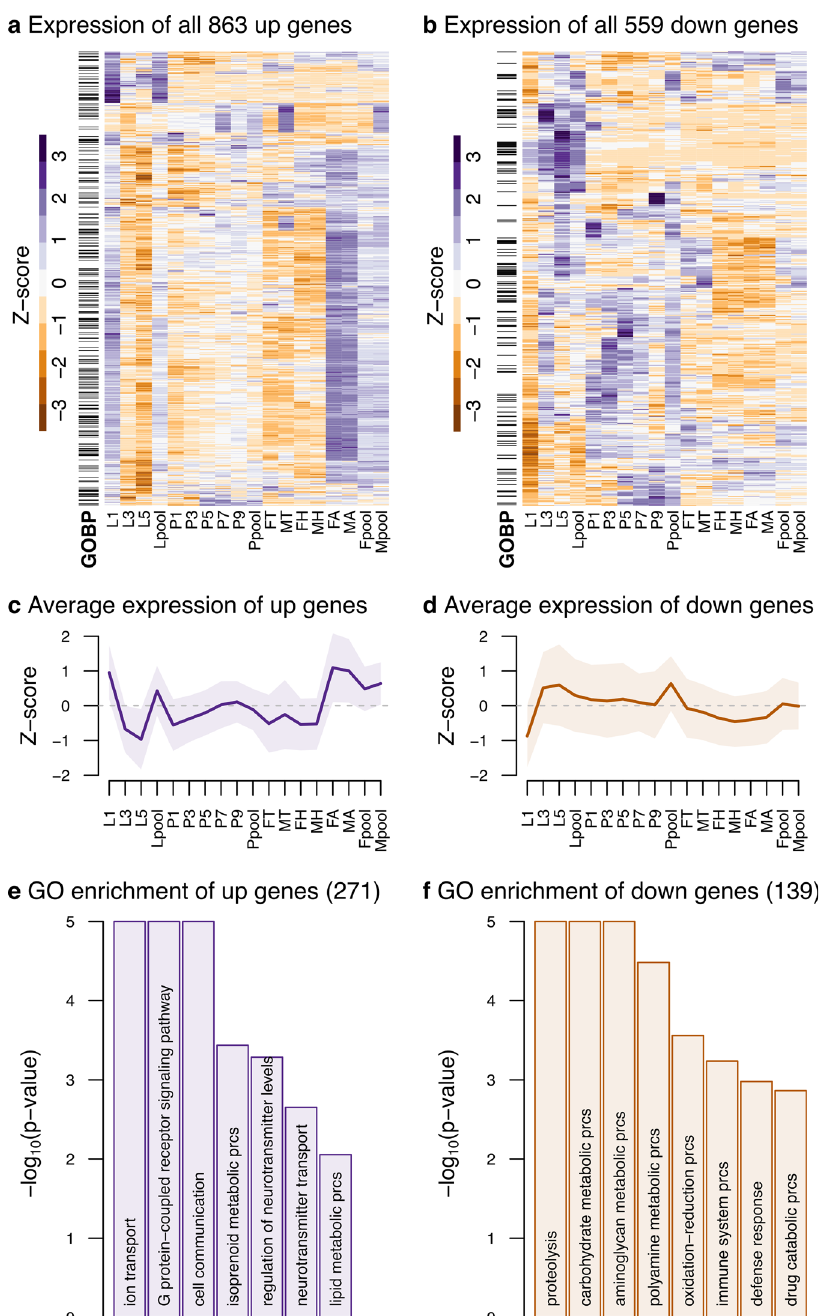
Fig. 3 Differential expression results for the L1:L contrast. a , b Heatmaps of differentially upregulated and downregulated genes (5% FDR) in L1 relative to the average of L3 and L5. The average of each pair of replicates is used for the columns, and the rows are scaled using a Z-score. c , d Average gene expression trend based on the Z-score scaled expression of all upregulated and downregulated genes across all samples, respectively. The shaded area represents ±1 SD from the mean. e , f Topmost signi fi cantly enriched Biological Process GO terms amongst upregulated and downregulated genes, respectively. Only GO terms with an associated q-value cutoff smaller or equal to 0.2 are plotted. Raw data for these fi gures can be found in Supplementary Data